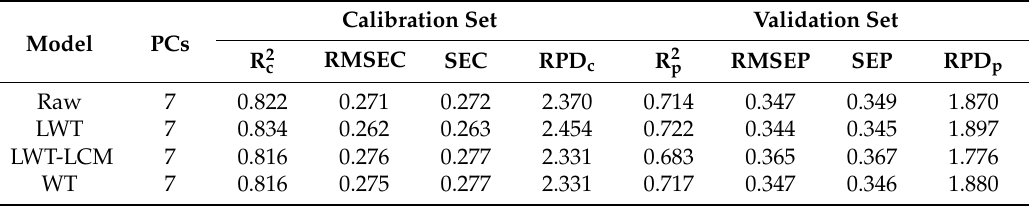
Table 4. Model statistics of wood tracheid length. Raw: raw model; LWT: model with LWT pretreatment; LWT-LCM: model with LWT coupled with LCM pretreatment; WT: model